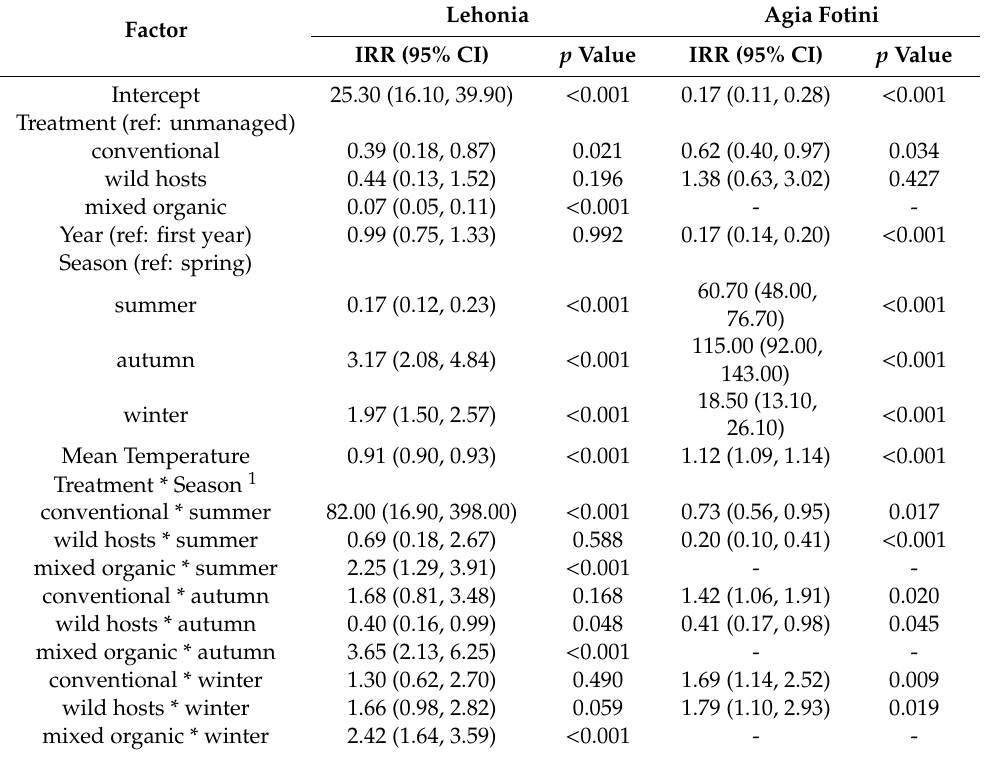
Table 4. Variables of the GEEs with significant e ff ects on the trap captures of adult Drosophila suzukii in the coastal area Lehonia and in the semi-highland area Agia Fotini.